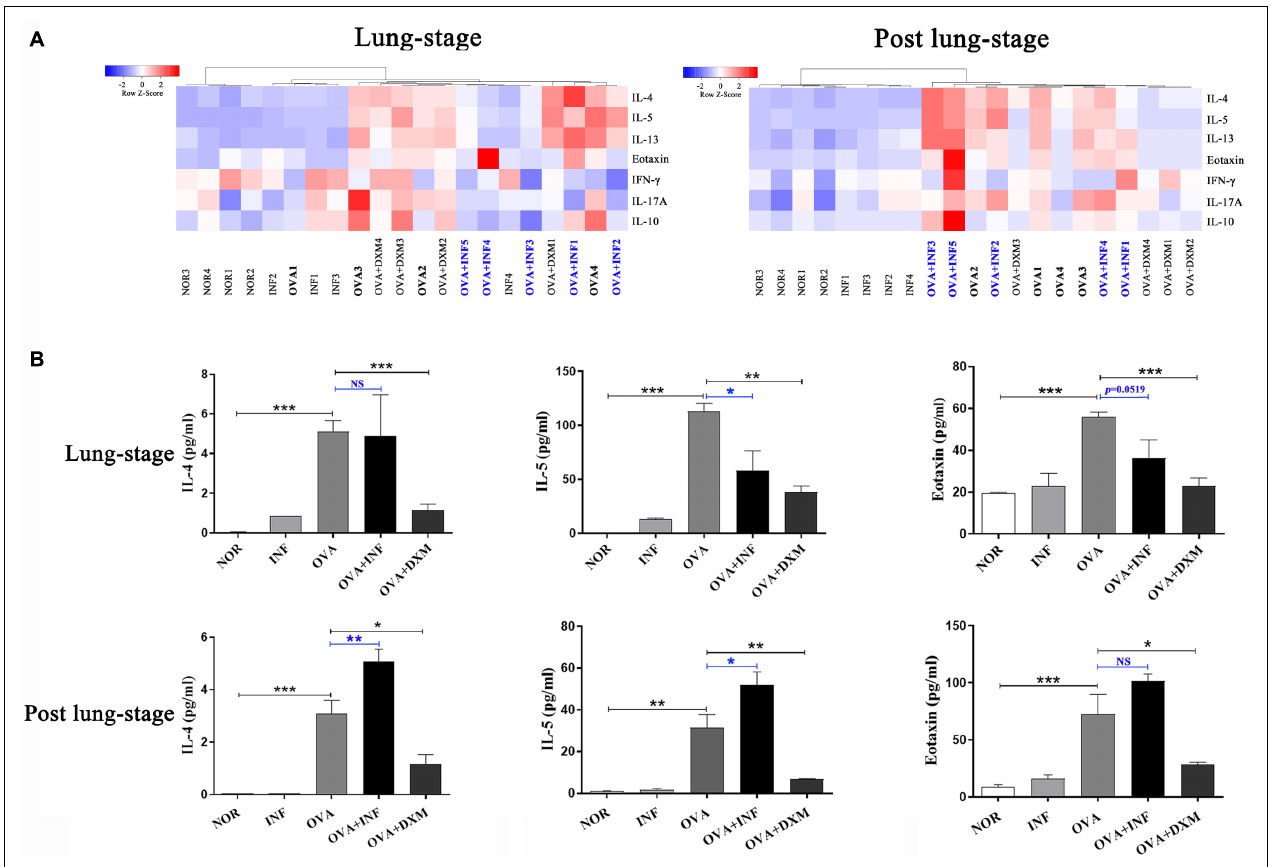
FIGURE 3 | Lung-stage S. japonicum infection inhibited T H 2 cytokine secretion after OVA challenge, while post–lung-stage infection did not. (A) Heatmaps of multiple cytokines in BALF of mice treated with lung-stage S. japonicum infection (left) and post–lung-stage S. japonicum infection (right) after OVA challenge by Luminex ( n = 5 or 6 mice per group, experiment performed twice). (B) Concentrations of IL-4, IL-5 and eotaxin in BALFs were compared among all groups ( n = 5 or 6 mice per group, experiment performed twice). Data are shown as mean ± SEM. * P < 0.05, ** P < 0.01, *** P < 0.001; NS, not significant by one-way analysis of variance (ANOVA) with Tukey